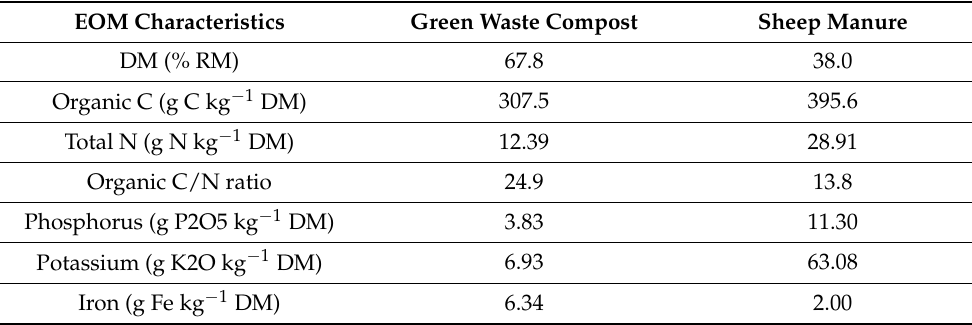
Table 3. Main characteristics of green waste compost and sheep manure applied in the field experiment. EOM Characteristics Green Waste Compost Sheep Manure DM (% RM) 67.8 38.0